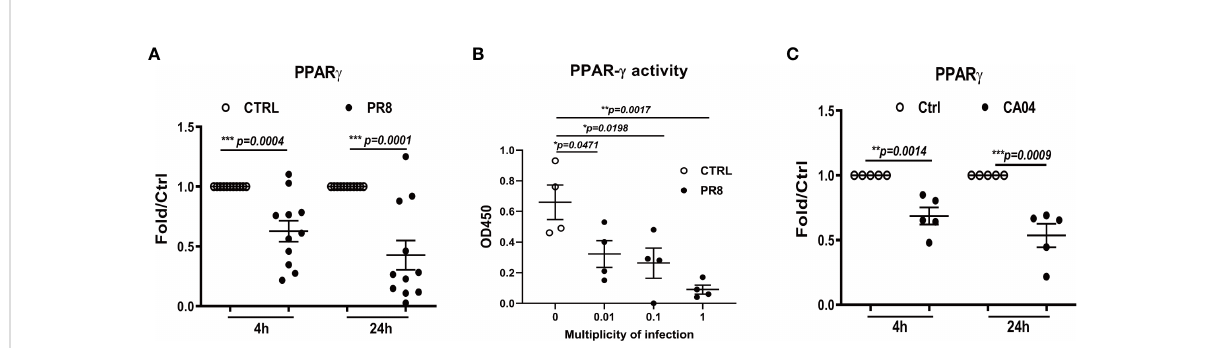
FIGURE 1 In fl uenza infection reduces PPARG gene expression and transcription activity in human alveolar macrophages(AMs). Cultured human AMs were infected with PR8 virus (A, B) or CA04 virus (C) at MOI=1, at 4 or 24 hpi, the cell pellet was harvested for RNA extraction, and the mRNA level of PPAR g was determined by RT-qPCR (A, C) . Human AM was infected with PR8 at MOI=0.01, 0.1, or 1, harvested the cell pellet for the nuclear protein extraction at 24 hpi, and the PPAR g transcriptional activity of PPAR g was determined (B) . Unpaired t test was applied for the statistical analysis of (A, C) and Ordinary one-way ANOVA was applied for B. *p < 0.05, **p < 0.01, and ***p <